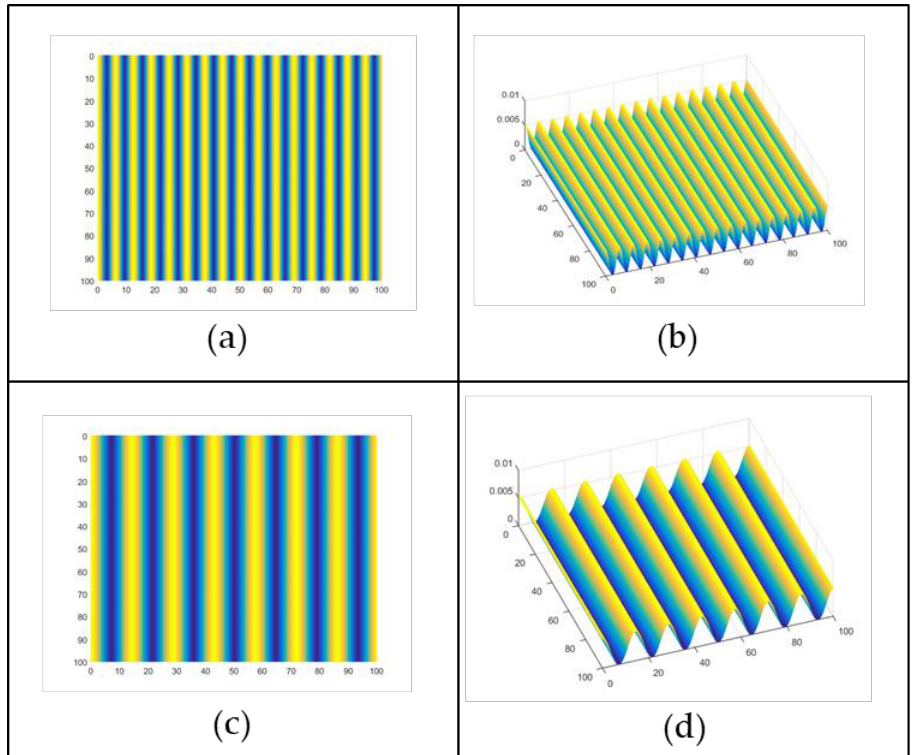
Figure 1. Pattern of light intensity produced by the interference of two beams: ( a , c ) top view and ( b , d ) 3D view. ( a , b ) are calculated with an angle of 67.5 degrees, while ( c ) is calculated with an angle of 81 degrees.